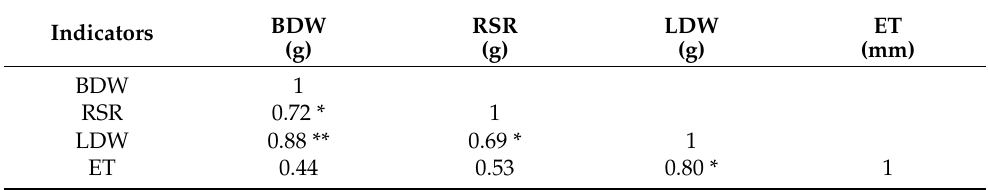
Table 3. Correlation among the measured indicators of BDW, RSR, LDW and ET. Indicators BDW